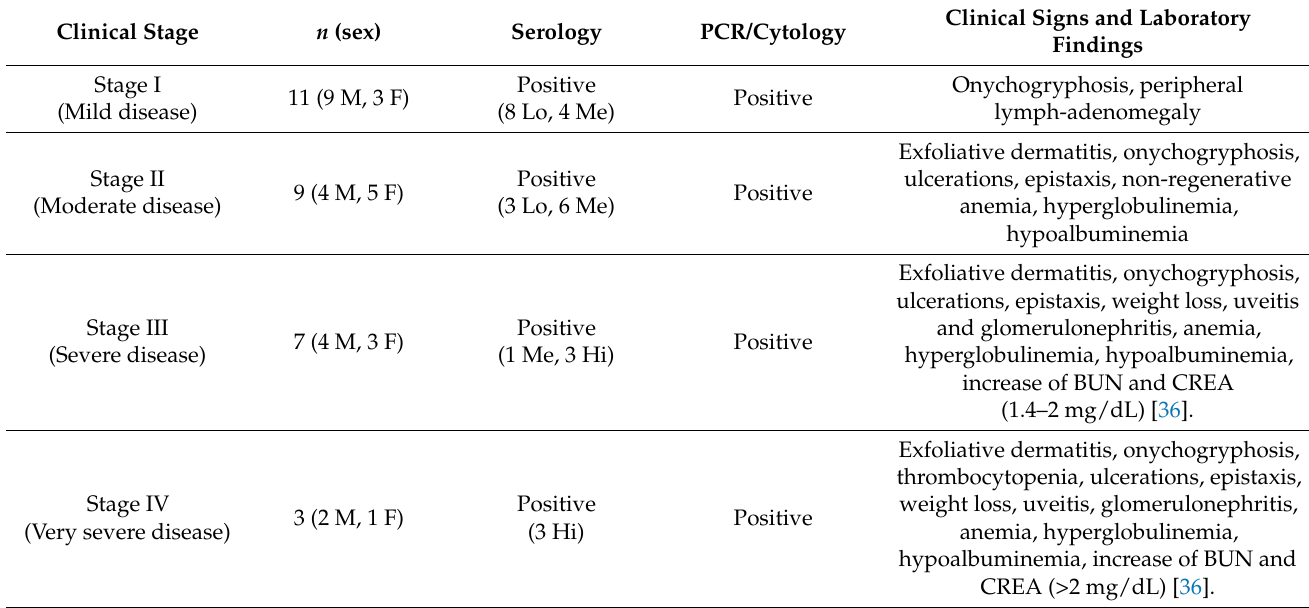
Table 1. Clinical staging of dogs affected by CanL (LEISH